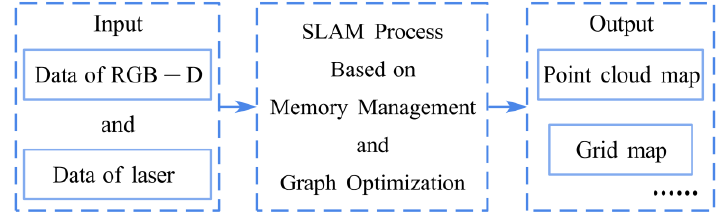
Figure 17. The RTAB-MAP mapping process based on vision and laser.